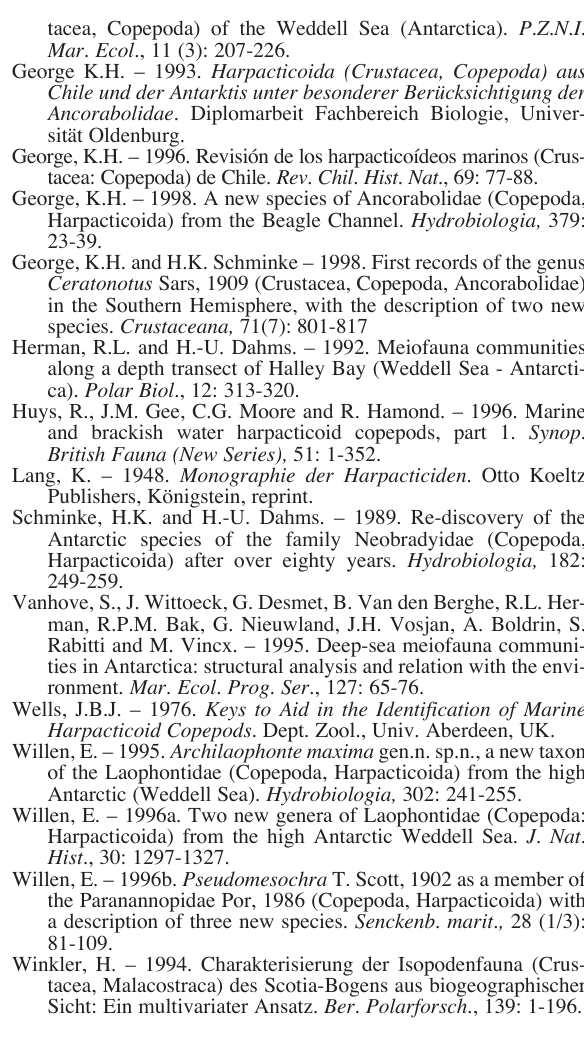
F IG . 2. – Graphical presentation of the relationship between the number of genera (left axis; shaded bars) and the number of specimens (abundances) (right axis; open bars) at each station. Stations 840-877 = “Magellan Area”, Stations 1033-1234 = “Beagle